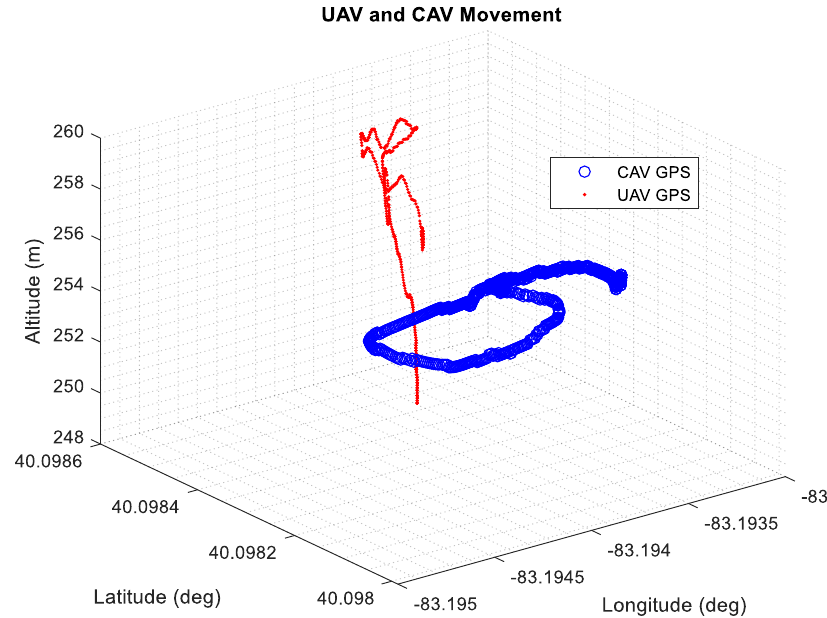
Figure 12. Latency analysis for Experiment #2.